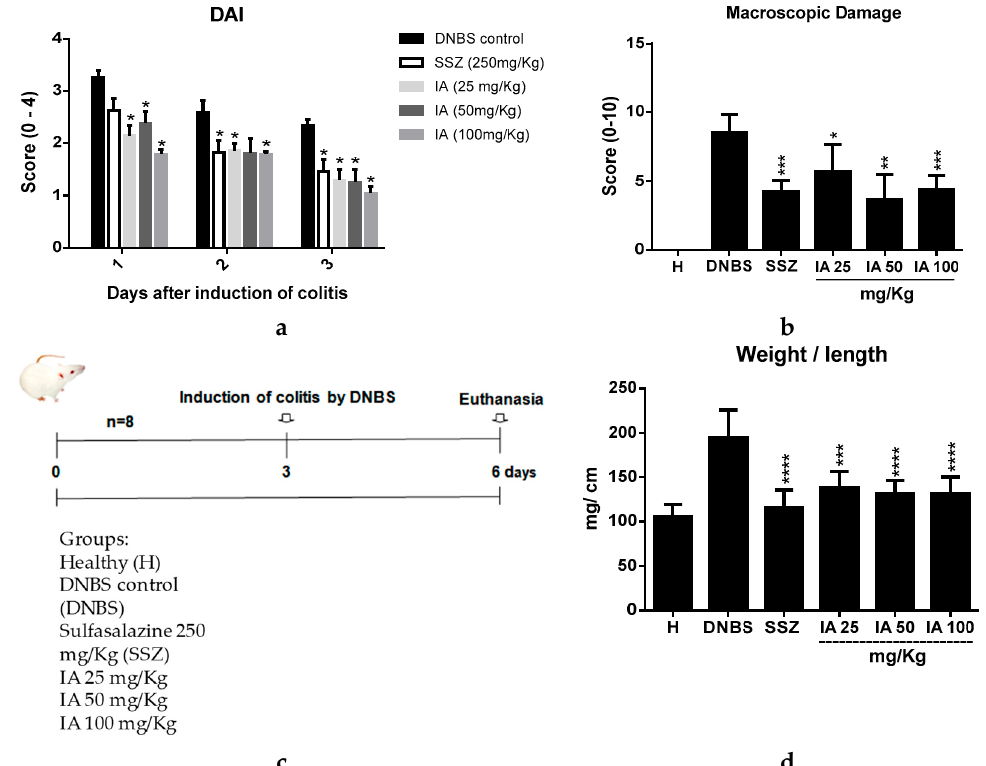
Figure 1. Experimental design and effect of 25, 50, and 100 mg/kg doses of I. asarifolia (IA) aqueous extract and 250 mg/kg of sulfasalazine (SSZ) on disease activity index (DAI) ( a ); macroscopic damage index (MDI) ( b ); experimental design ( c ); weight/length relationship of the colon ( d ) of the different groups in the experimental trial of acute colitis induced by 2,4-dinitrobenzene sulphonic acid (DNBS) in rats. H, Healthy group; DNBS, DNBS group; SSZ, Sulfasalazine group; and the 25, 50, and 100 mg/kg doses of IA. Data are expressed as mean ± SEM, ( n = 8). Statistical differences * p < 0.05, ** p < 0.01, *** p < 0.001 and **** p < 0.0001 of treatments vs. DNBS control were presented.